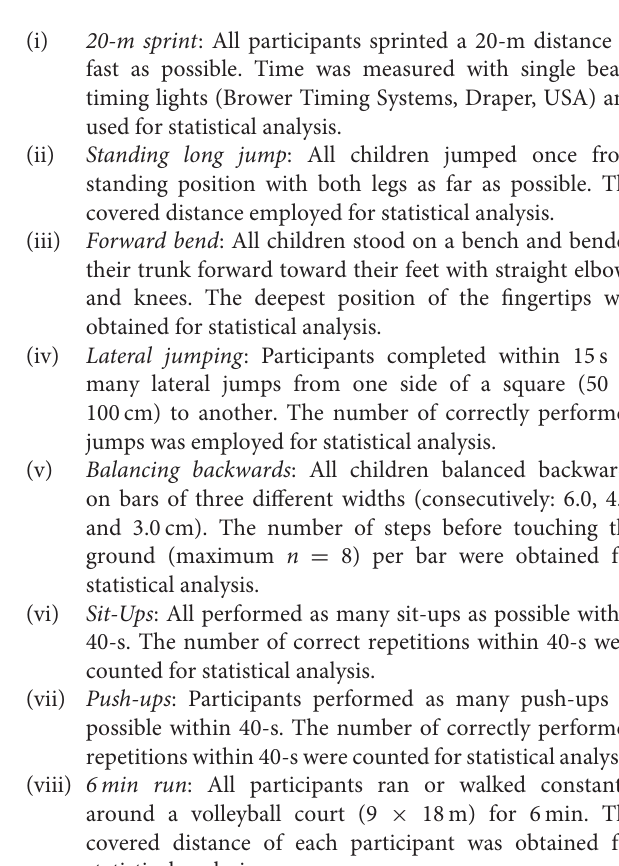
repetitions within 40-s were counted for statistical analysis. around a volleyball court (9 × 18 m) for 6 min. The covered distance of each participant was obtained for statistical